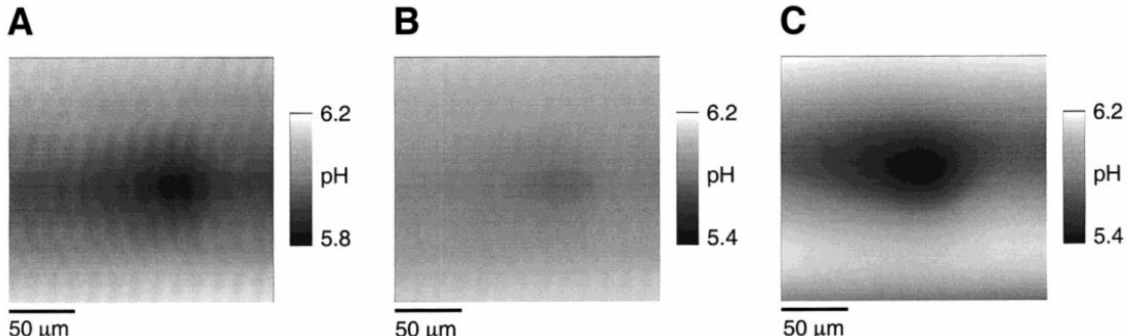
Figure 4. A pH imaging of glucose oxidase immobilized onto a carbon microelectrode substrate (33 µ m diameter). ( A ) Image obtained with FeCp 2+ in solution and the substrate at open circuit. ( B ) Same as ( A ) but plotted on the same pH scale as ( C ) for comparison purposes. ( C ) Image obtained with the substrate biased at +0.6 V to regenerate FeCp 2+ from FeCp 2 produced by an enzymatic reaction. Reprinted with permission from reference [17]. Copyright 2000, American Chemical